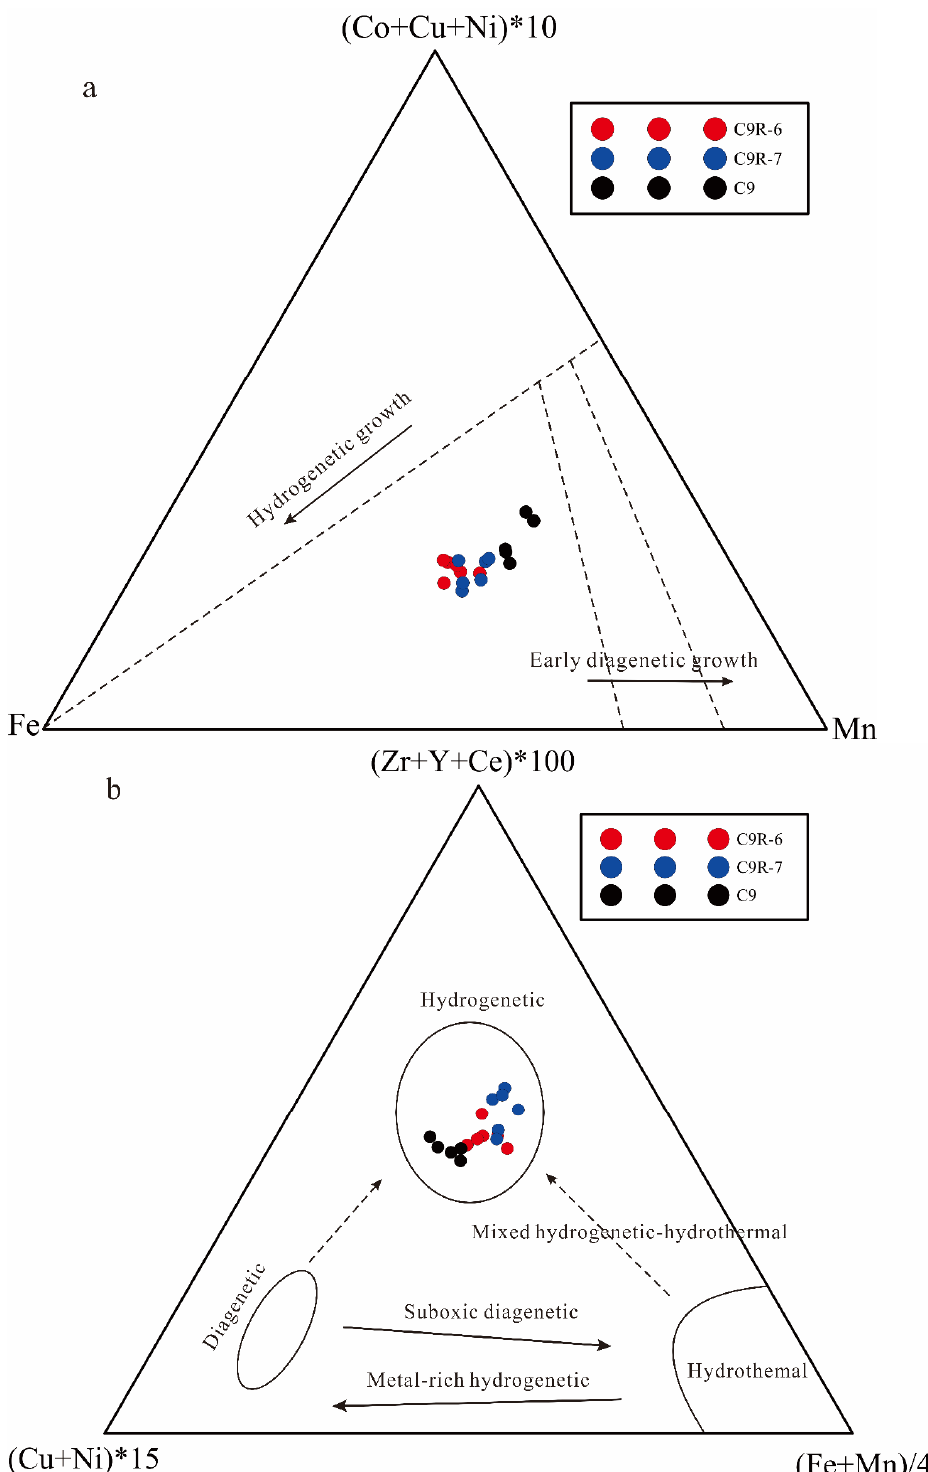
Figure 8. ( a ) Ternary diagram for the genetic classification of ferromanganese deposits. ( b ) Ternary discrimination diagram for the genetic classification of ferromanganese deposits.